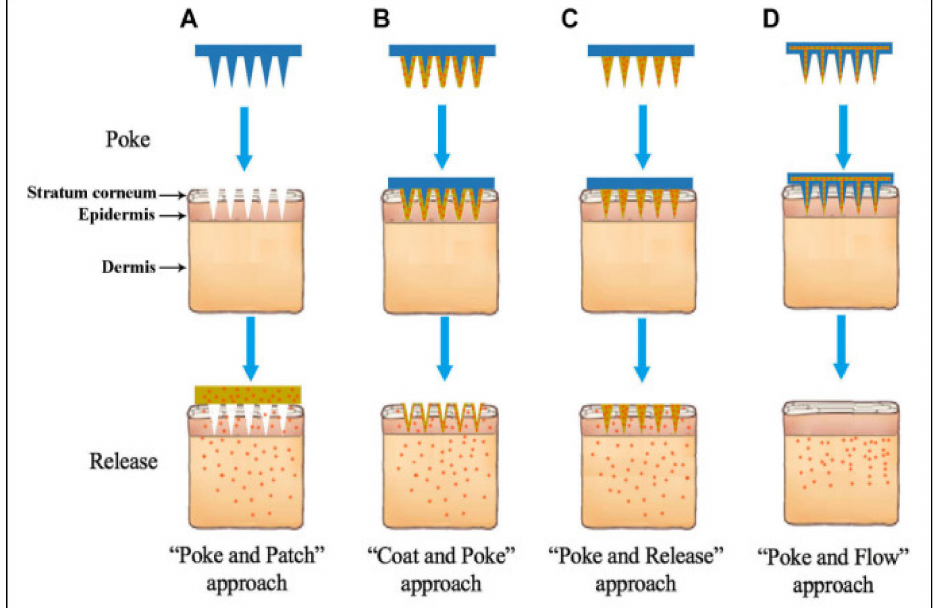
Figure 2. Diagrams showing various microneedle drug delivery approaches. ( A ) Solid microneedles, for skin pretreatment to create microchannels, followed by the application of transdermal patch; ( B ) coated microneedles, for deposition of drug formulations into the skin, followed by removal of microneedles; ( C ) dissolving microneedles, incorporated into the substrate of microneedles, remaining in the skin and dissolving over time to release the drugs; and ( D ) hollow microneedles, for inserted into the skin and continuous infusion of the drug through the created microchannels [56]. (Adapted from Ref.